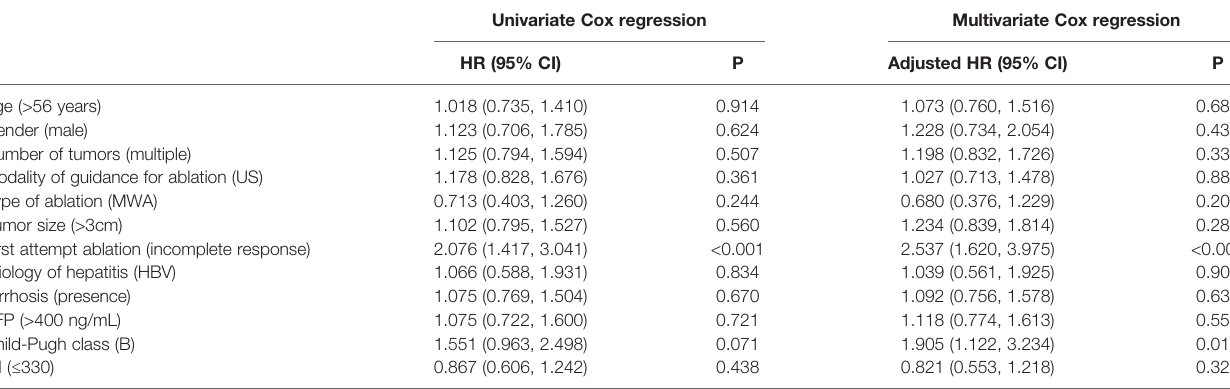
TABLE 3 | Univariate and multivariate Cox regression analysis for PFS.